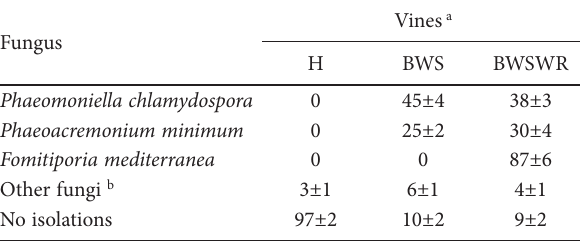
a For each group of vines, data are means for 900 woody chips ± standard deviation. b Penicillium spp., Alternaria spp., Paecilomyces spp., Trichoderma spp., Chaetomium spp., Cladosporium spp., Paraconiothyrium spp. and sterile